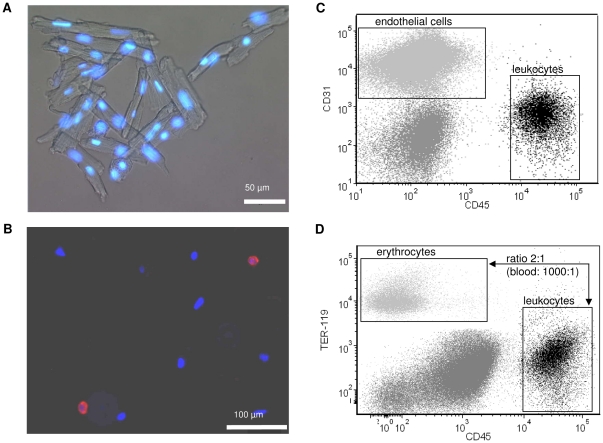
Analysis of the different cell fractions present within the unstressed heart.Fluorescence microscopy of intact murine cardiomyocytes (A) and non-cardiomyocytes (B) extracted from the murine heart. Red = CD45+ cells (fluorescence microscopy). Blue = nuclear stain with DAPI. C: Representative flow cytometry plot of non-cardiomyocytes. Black = CD45+ cells (lower right), light grey = endothelial cells (CD31+, upper left) and dark grey = CD31− CD45− (lower left). D: Representative Ter-119/CD45 plot of non-cardiomyocytes to derive the ratio of erythrocytes to leukocytes in myocardial tissue. Assuming a ratio of erythrocytes/leukocytes in peripheral blood to be 1000∶1, contamination of blood derived leukocytes was calculated to be <0.2% (n = 5).